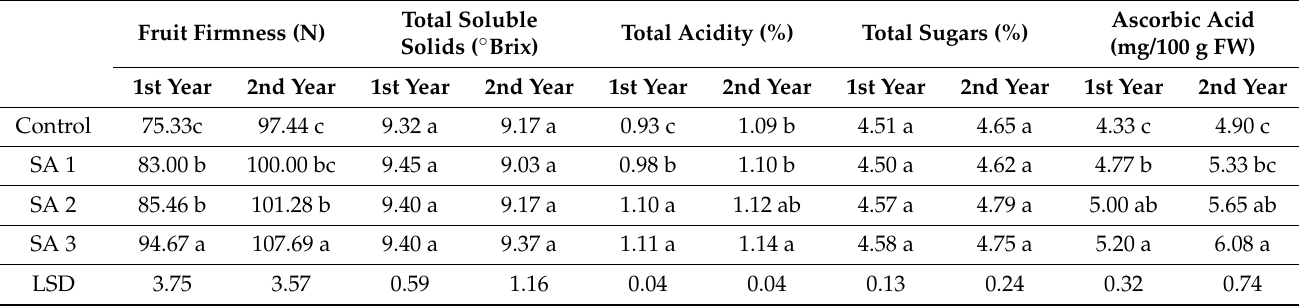
Table 2. Effects of different pre-harvest treatments of SA on the peach fruit physicochemical characteristics at harvest in the 1st and 2nd